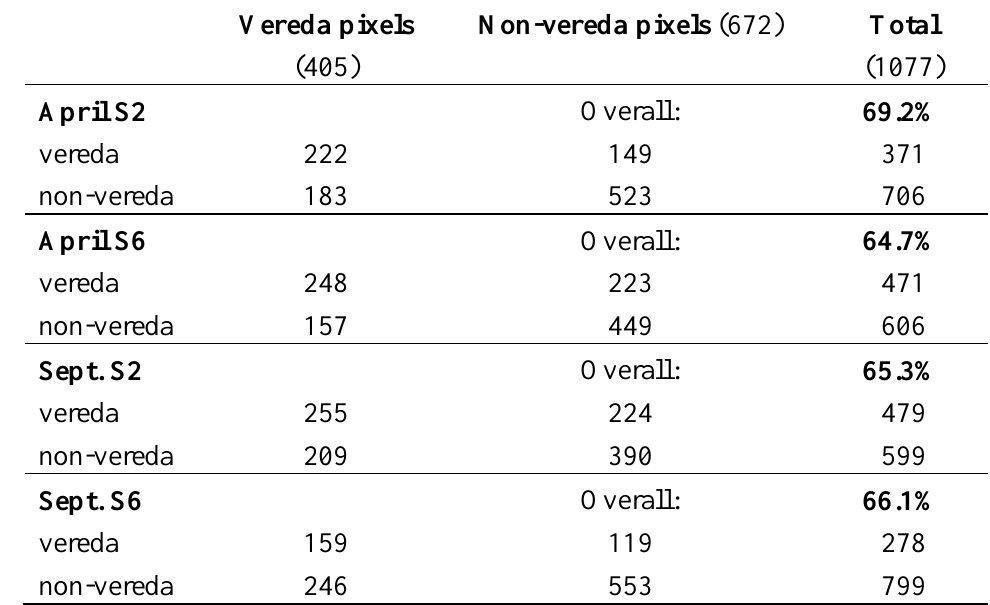
Table 4 . Confusion matrices and overall success for the classification of the four Radarsat- 1 images into vereda (excluding grassland) and non- vereda